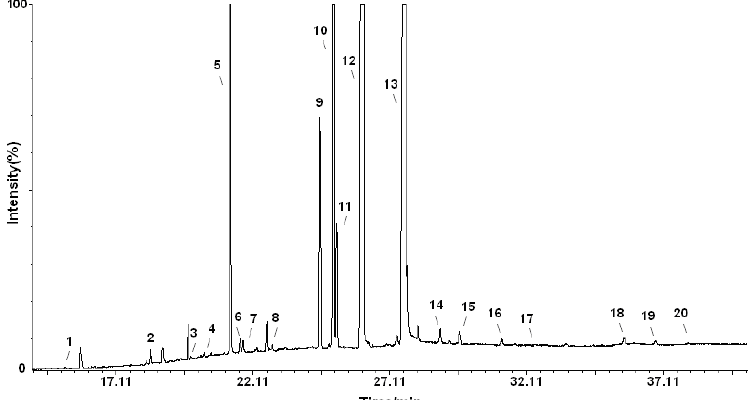
Figure 1. GC-MS chromatogram of FAMEs in the TLs of Sambucus nigra L. seeds analyzed with a SUPELCOWAX 10 capillary